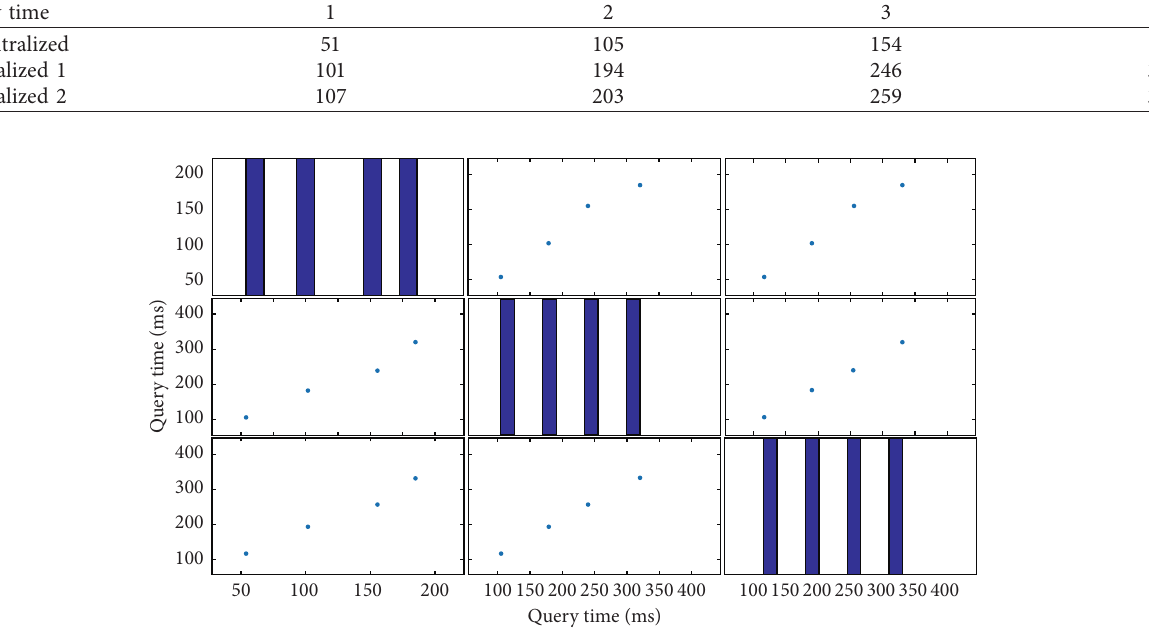
Figure 7: Query rate comparison